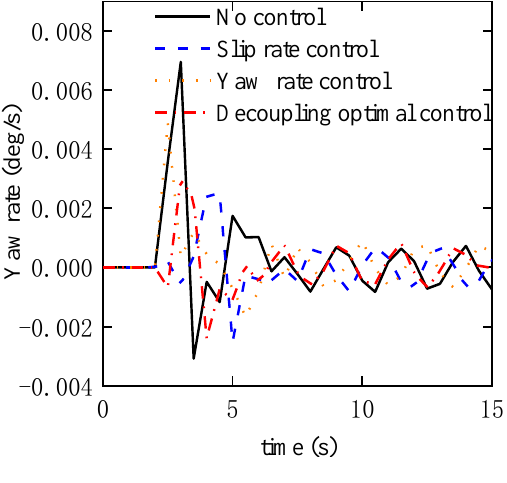
Figure 10. Yaw rate.